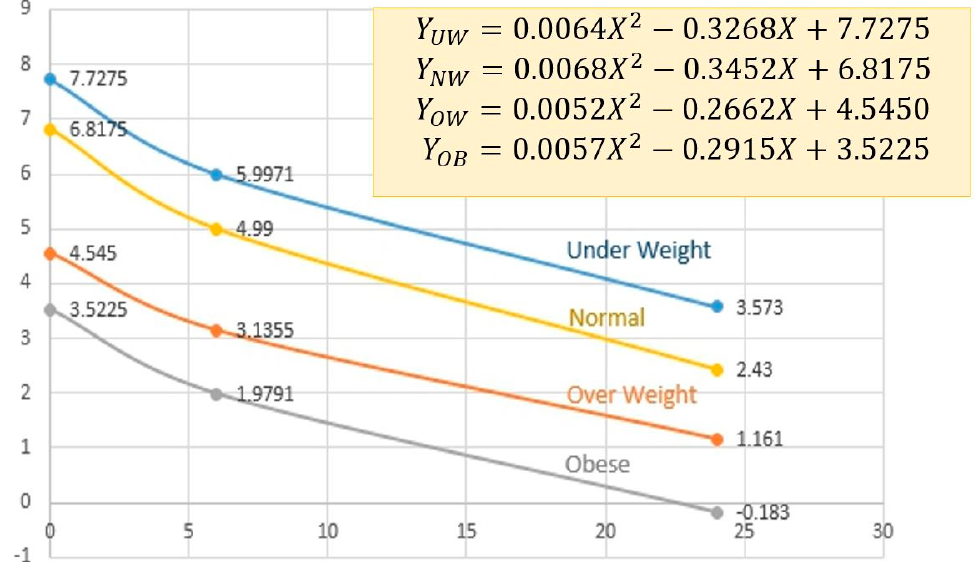
Figure 4. Weight retention estimation from 0 to 24 weeks postpartum, with pre-pregnancy BMI types.